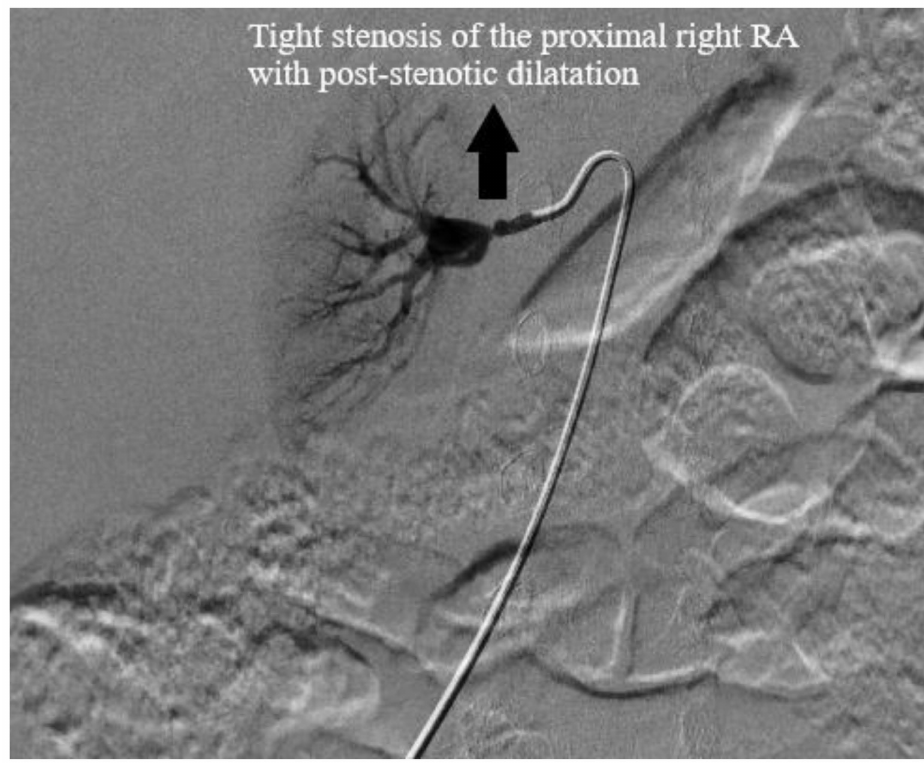
Figure 3. Digital subtraction angiography of the right renal artery, which showed proximal renal artery